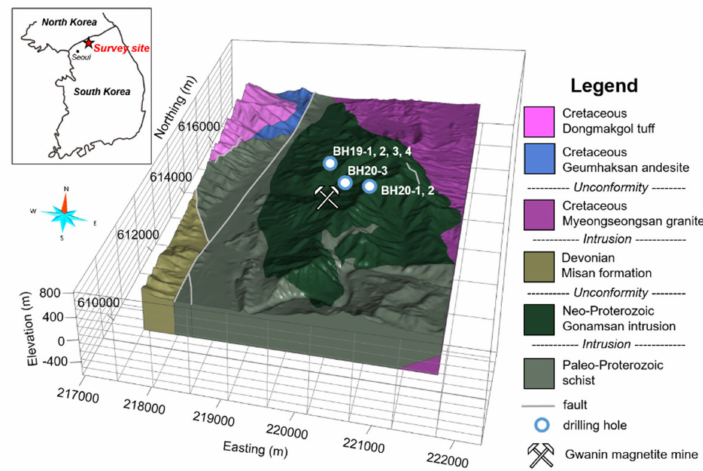
Figure 1. Three-dimensional geologic model of the Gonamsan intrusion